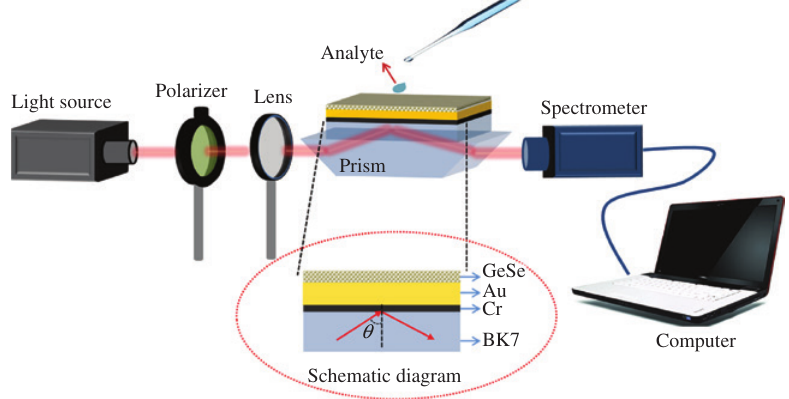
Figure 1: Experimental set-up for SPR sensor